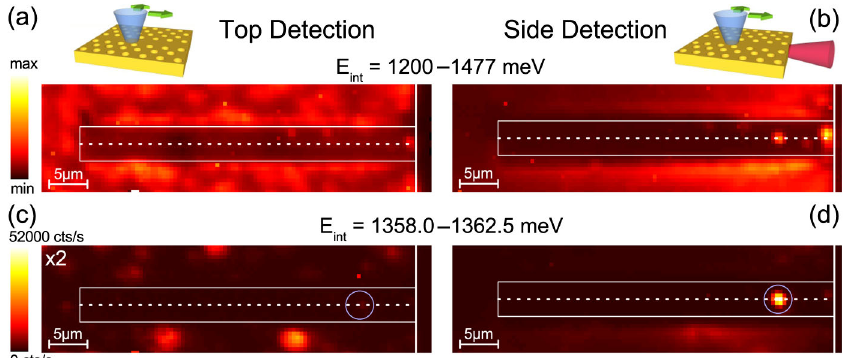
FIG. 2. Comparison of the PL intensity for top and side detection. Spatially-resolved PL scan performed with (a), (c) detection from the top, and (b), (d) detection from the cleaved facet of the waveguide. The PL intensity is integrated over the spectral range of the ¼ 1200 – 1477 meV in (a) and (b), and over the limited spectral range of a single quantum wetting layer and quantum dot emission E int ¼ 1358 : 0 – 1362 : 5 meV in (c) and (d). The dotted white lines mark the position of the PWG, while the plain white lines dot E int indicate the outline of the photonic crystal structure and the cleaved edge of the